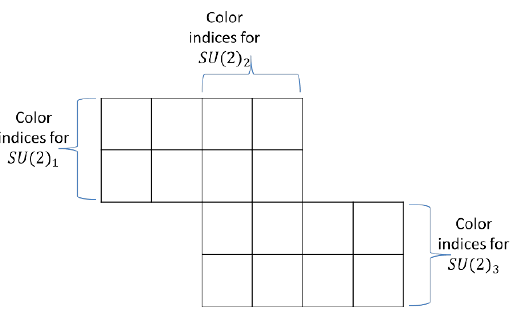
Figure 1 . This (cid:12)gure shows the tetris diagram for SU(2) 3 theory. Every box (one square) represents one component of a hypermultiplet. The diagram should be read from left-up to right-down. The (cid:12)rst two columns represent two fundamentals of SU(2) 1 . The 2 (cid:2) 2 block to their right represents one bifundamental of SU(2) 1 (cid:2) SU(2) 2 . The 2 (cid:2) 2 block below it, represents one bifundamental of SU(2) 2 (cid:2) SU(2) 3 . Finally, the last two columns represent two fundamentals of SU(2) 3 . need to give VEV to several scalars such that for every SU( N ) factor we have a baryon, a meson or nothing getting VEV. See (cid:12)gure 2 for some